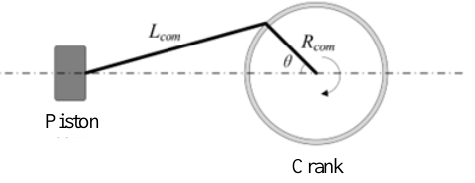
Figure 5. Schematic diagram of geometric structure of piston compressor.